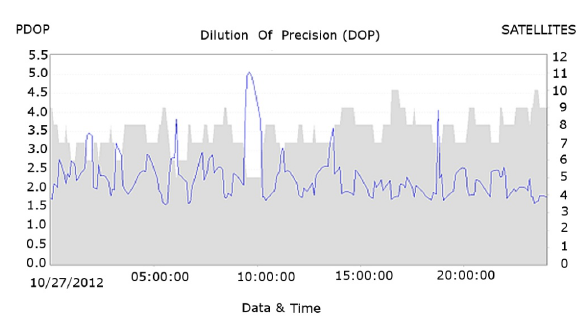
Figure 4: PDOF value and number of available satellites for GPS system obtained in Leica Geo Oflce 8.2.